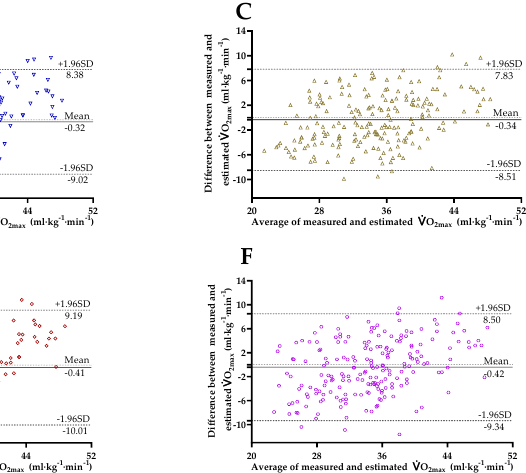
Figure 3. Bland–Altman Plots comparing the differences between measured and estimated V model BC ( A ), PBF model HR0 ( B ), PBF model ∆ HR3 − HR4 ( C ), BMI model BC ( D ), BMI model HR0 ( E ), BMI model ∆ HR3 − HR4 ( F ) in the entire sample ( n = 205). The mean differences and 95% limits of agreement are shown as solid lines and dashed lines, respectively.